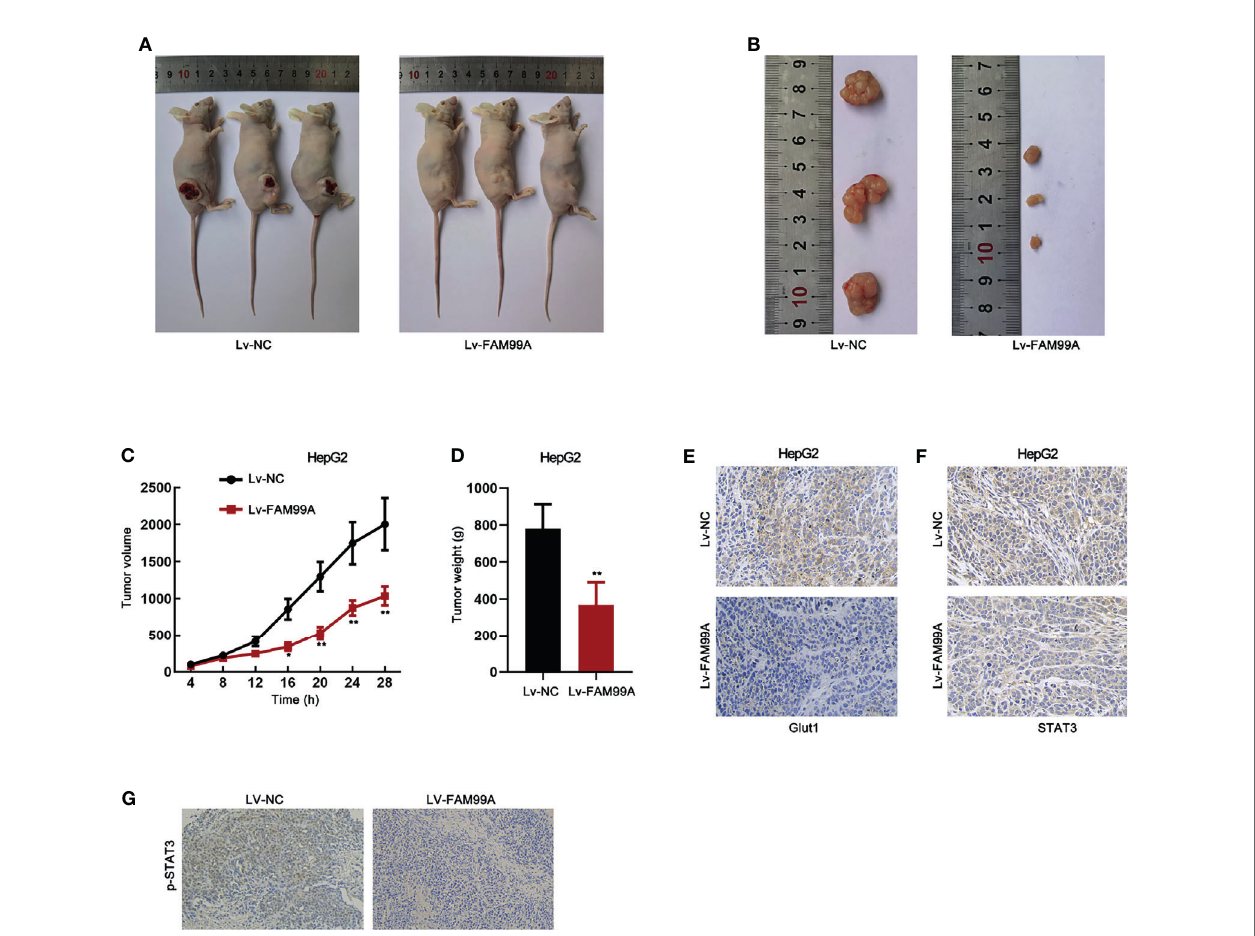
FIGURE 8 | Effect of FAM99A on HCC in a xenograft model. (A) Pictures of mice with tumors generated by injected HepG2 cells transfected with Lv-FAM99A or lv- NC. (B) Pictures of dissected xenografts of each group. (C) The growth curve of xenografts was plotted by measuring the tumor volume in mice every 4 days after injection of transfected cells. (D) Tumor weight was evaluated after the tumors were dissected after 28 days. (E) The expression of GLUT1 in tumor tissues was detected by immunohistochemistry assay. (F) The expression and location of STAT3 in HepG2 was examined by immunohistochemistry assay. (G) The existence of p-STAT3 in tumor tissues was detected by immunohistochemistry assay. * p < 0.05, ** p <